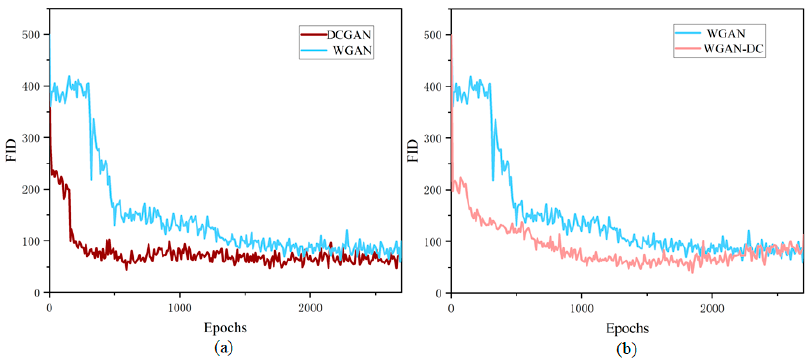
Figure 8. The comparison of FID curves: ( a ) DCGAN and WGAN; ( b ) WGAN and WGAN-DC.